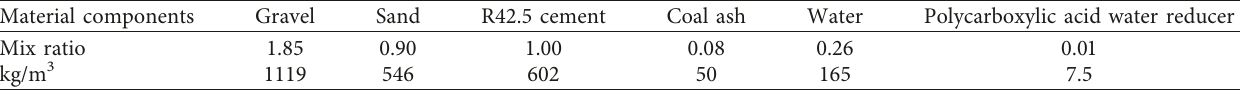
Table 2: C60 concrete mix ratio.